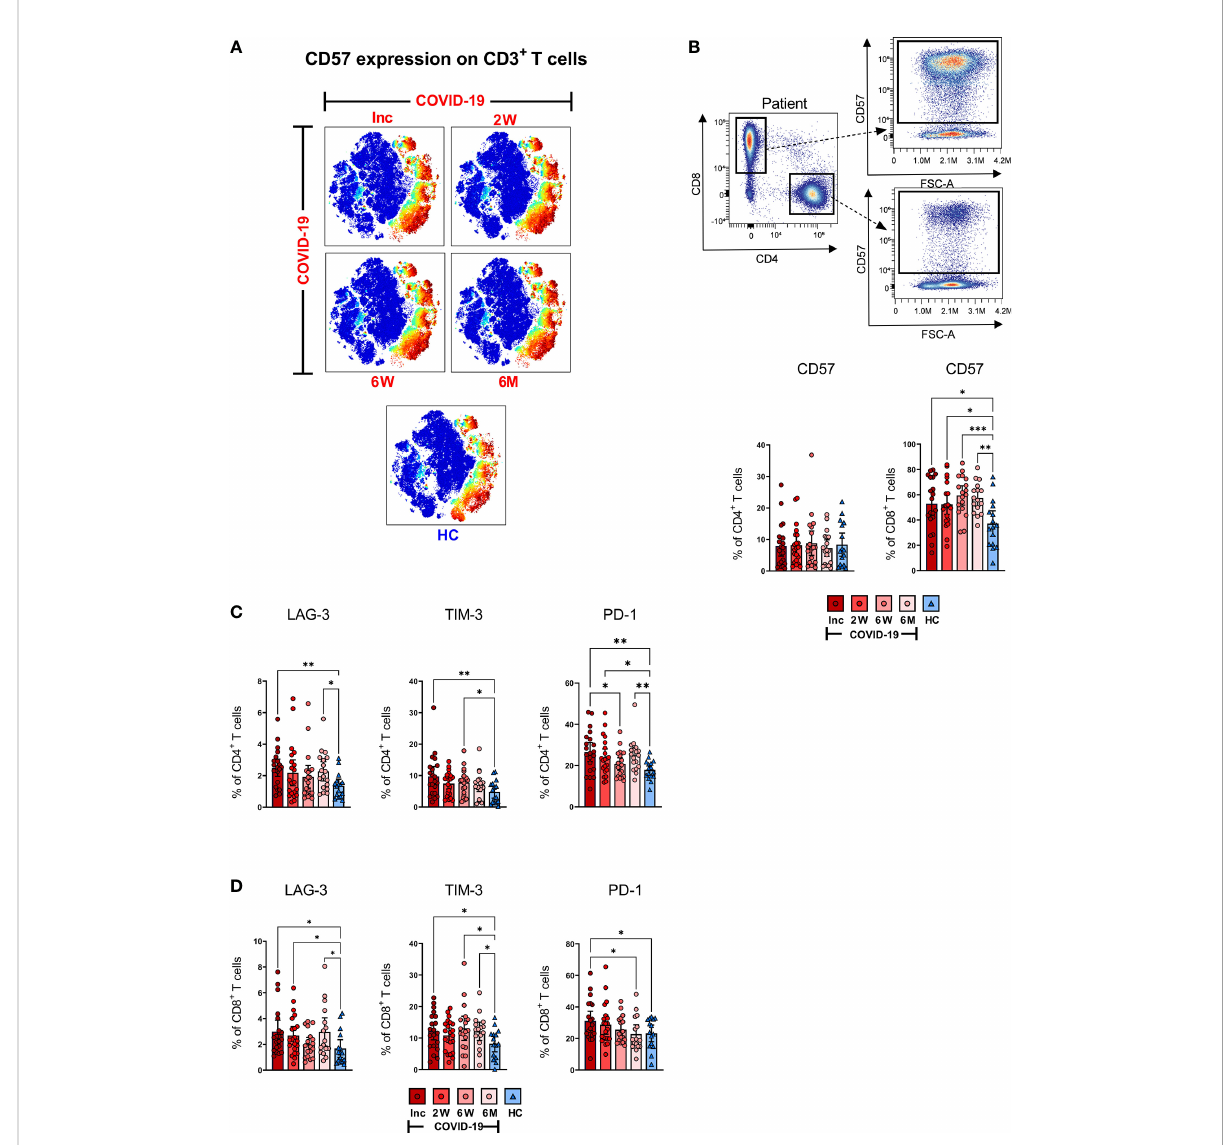
FIGURE 5 T cell impairment associated with COVID-19. PBMCs collected from COVID-19 patients that needed hospitalization (N=23) and healthy controls (N=16), were stained for fl ow cytometry to assess the expression of negative immune checkpoint factors and exhausted status of CD4 + and CD8 + T cells. (A) tSNE plots displaying CD3 + cells, colored according to intensity of CD57 expression. (B) Representative fl ow cytometry plots for CD57 expression levels on CD4 + and CD8 + T cells, as well as the frequency of CD57 + CD4 + and CD8 + T cells. Expression frequencies of LAG-3 + , TIM-3 + and PD-1 + cells among (C) CD4 + and (D) CD8 + T cells. Data is represented as mean with 95% Cl, with signi fi cance of *p ≤ 0.05, **p ≤ 0.01, ***p ≤ 0.001, determined using Brown-Forsythe and Welch ANOVA tests. Inc, Inclusion in study at the hospital; 2W, 2 weeks; 6W, 6 weeks; 6M, 6-7 months; HC, healthy